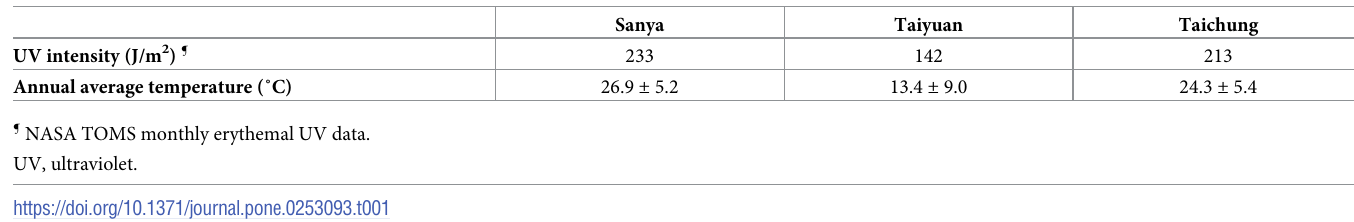
quency of wearing prescription glasses, sunglasses, or hats while outdoors. This study adhered to the tenets of the Declaration of Helsinki and was performed with the approval (No. I376) of Table 1. Climatic conditions in the three